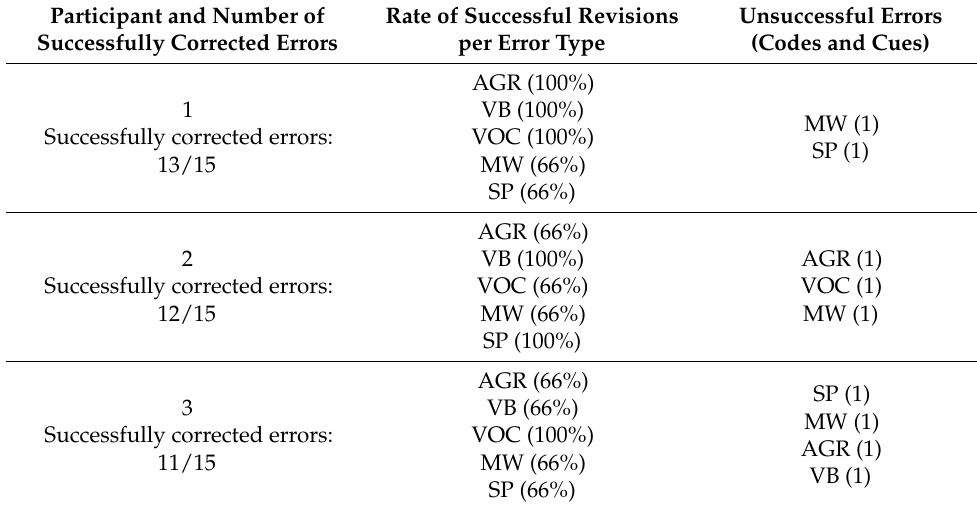
Table 6. Errors per